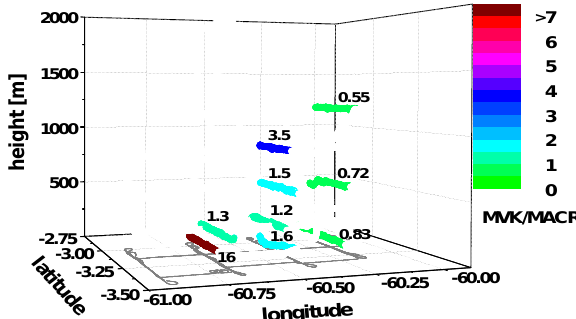
Fig. 11. 3-D image of the MVK/MACR ratios (GC-FID analy- sis) observed downwind of Manaus City ( − 3.08 ◦ , − 60.01 ◦ ) during Flight #18 on 19 July 2001, 10:00–14:00LT. Generally low ratios were also confirmed by the GC-MS analysis (data not shown). One longitudinal degree corresponds to ∼